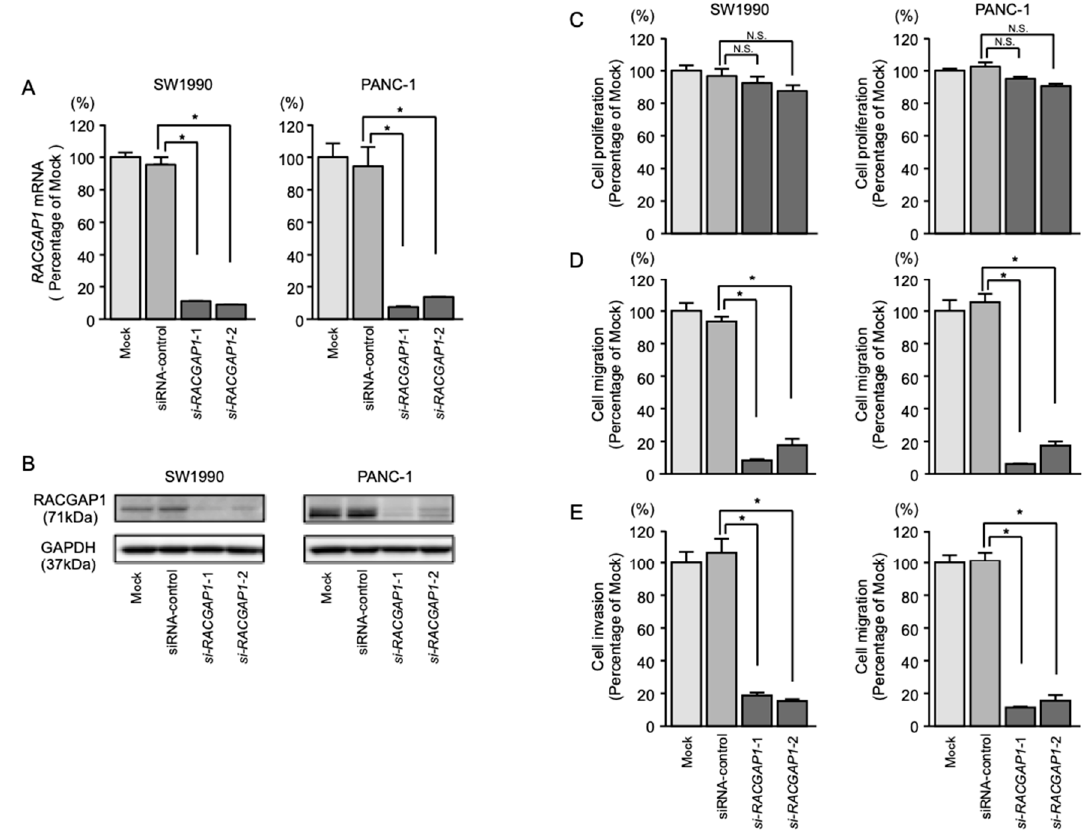
Figure 5. Effects of RACGAP1 knockdown by si- RACGAP1 transfection into PDAC cells. ( A ) RACGAP1 mRNA expression in PDAC cell lines was evaluated by qRT-PCR at 72 h after transfection with si- RACGAP1 -1 or si- RACGAP1 -2. GUSB expression was evaluated as the internal control. ( B ) RACGAP1 protein expression in PDAC cell lines was evaluated by western blotting at 96 h after transfection with si- RACGAP1-1 and si- RACGAP1-2 . GAPDH expression was used as the loading control. ( C ) Cell proliferation was assessed by XTT assays 72 h after transfection with 10 nM si- RACGAP1 -1 or si- RACGAP1 -2. ( D ) Cell migration was assessed by migration assays. * p < 0.0001. ( E ) Cell invasion was assessed by Matrigel invasion assays. * p <